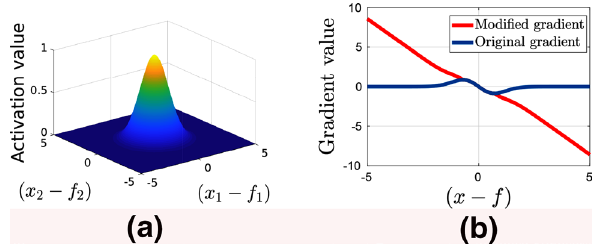
Fig. 12 Value of the activation function g ( 𝐱 , 𝐟 ) for Al-filter of length 2 ( a ) and the original and modified gradients of a 1-dimensional g ( 𝐱 , 𝐟 ) ( b ). The original gradient (16) becomes zero for large values 2 𝐱 − 𝐟 of 2 , but then its modified version (4) prevents the vanishing issue when the gradient tends to ‖ ‖